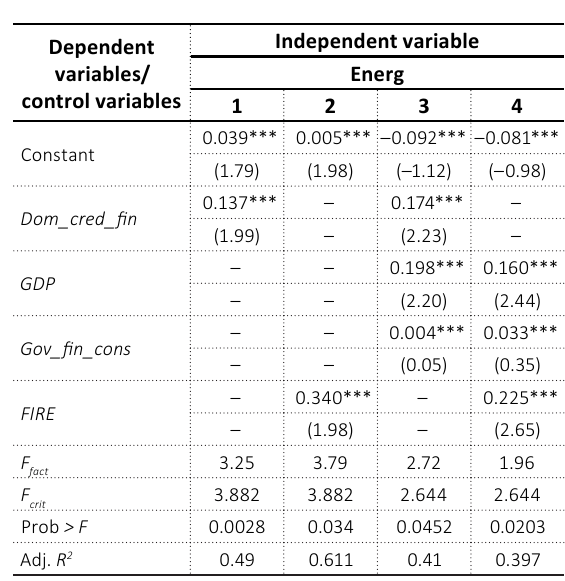
Table 1. Results of identifying the dependency